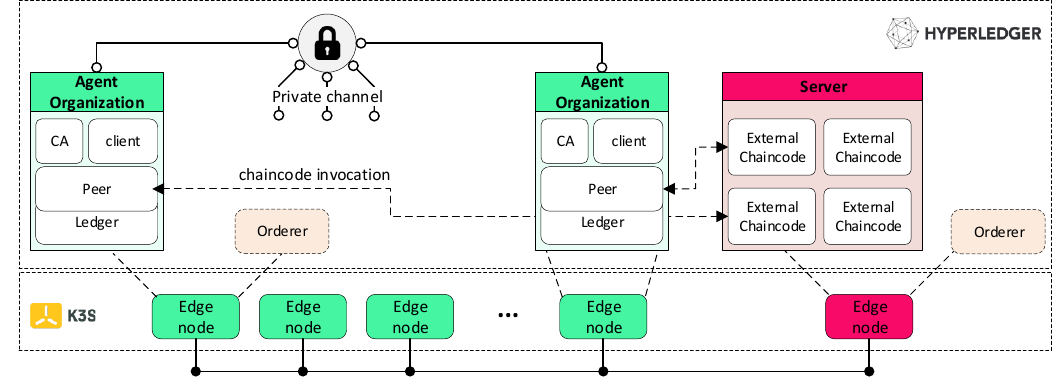
Fig. 3. HLF-Kubed architecture